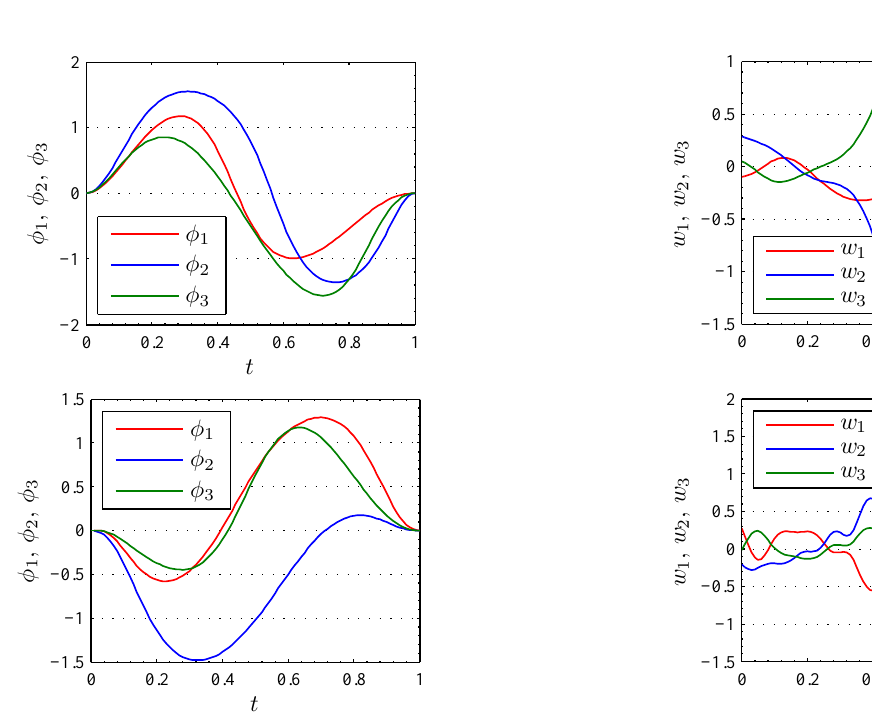
Figure 7. Linearized control u ( t ), egalitarian solution (top) and pri- oritarian solution (bottom).